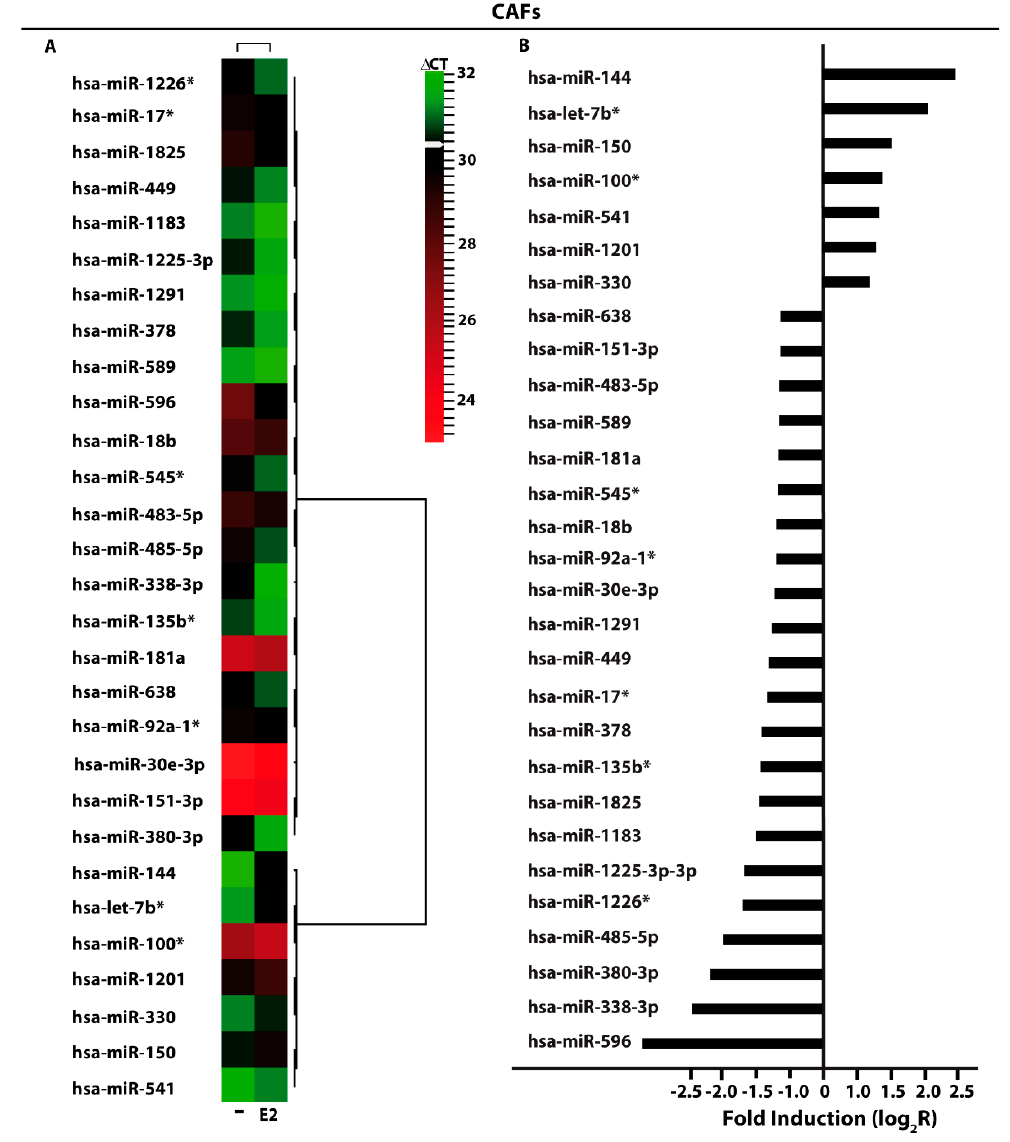
Figure 2. E2-modulated miRNAs expression in CAFs. ( A ) Heat Map representation of E2-modulated miRNAs in CAFs treated with 100 nM E2 for 4 h and analyzed by TaqMan Low-Density Array Human miRNA. Row represents a miRNA and column represents the treatment used. Each column is illustrated according to a color scale from green (low expression) to red (high expression). The distance measured is Euclidean Distance and the clustering method is complete linkage. Dendrograms of clustering analysis for miRNAs and samples are displayed on the top and right, respectively. ( B ) Up- and down-regulated miRNAs in CAFs upon E2 stimulation. The values are indicated as log2 fold change (R) calculated respect to vehicle (-).